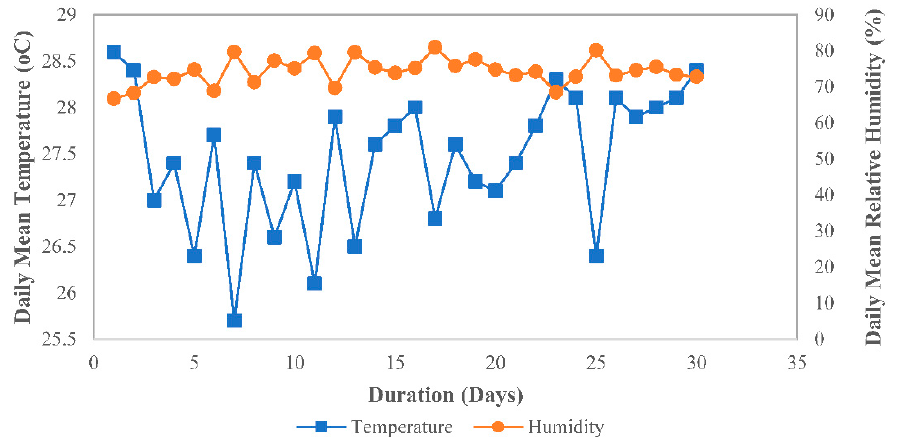
Figure 8. Daily mean temperature and relative humidity in April 2022.